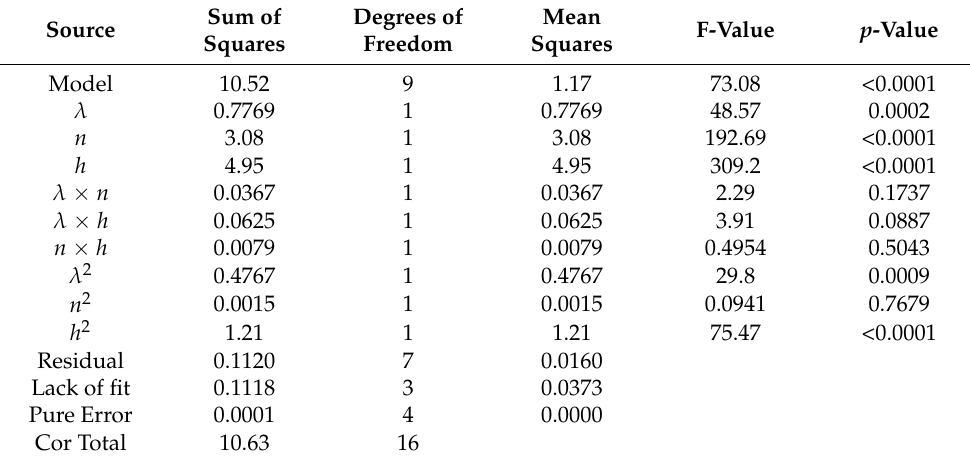
Table 4. ANOVA results of Ra.